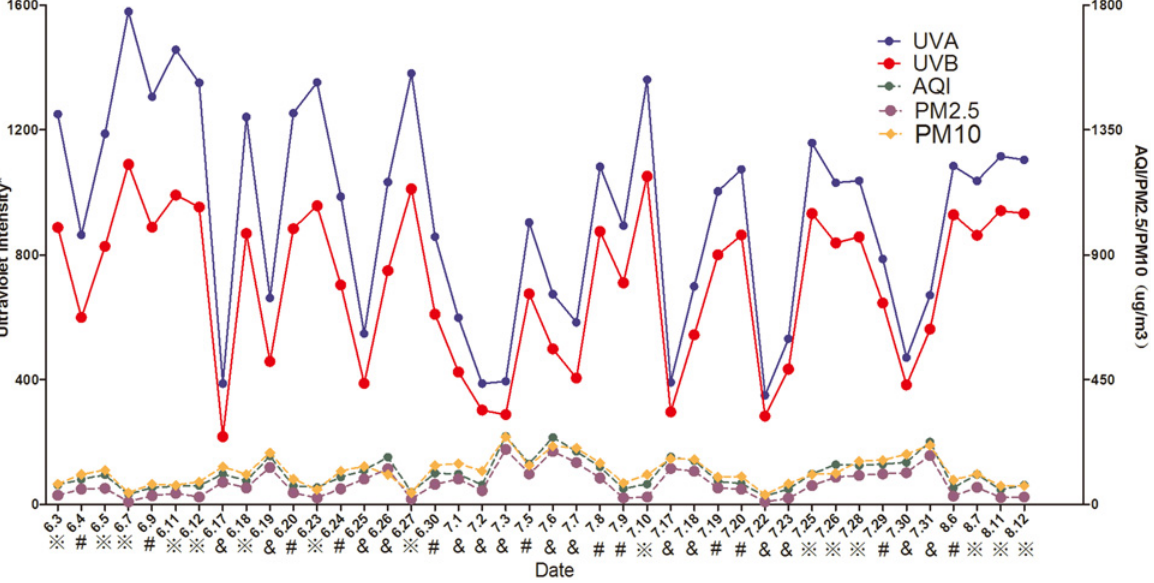
Fig 1. Changes in ultraviolet light intensity and air quality on all the experimental days. ※ clear day, # cloudy, and & overcast. * The UVA and UVB data are presented in μ W/cm 2 and 10× μ W/cm 2 , respectively.